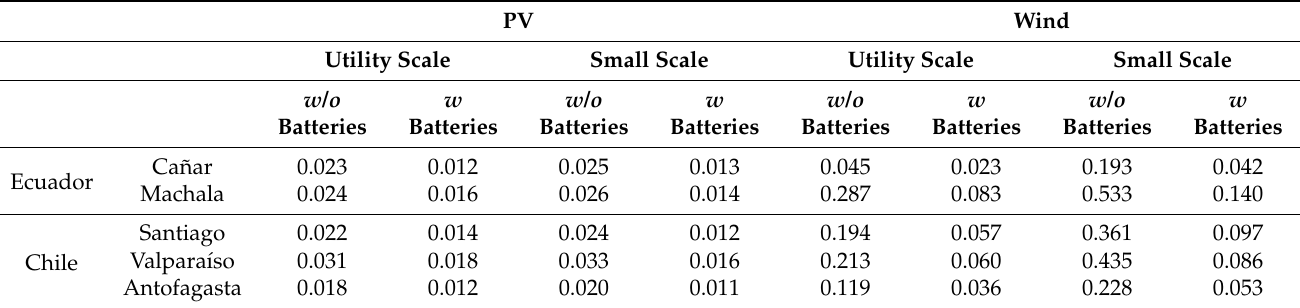
Table 4. LCOE ( € /kWh)